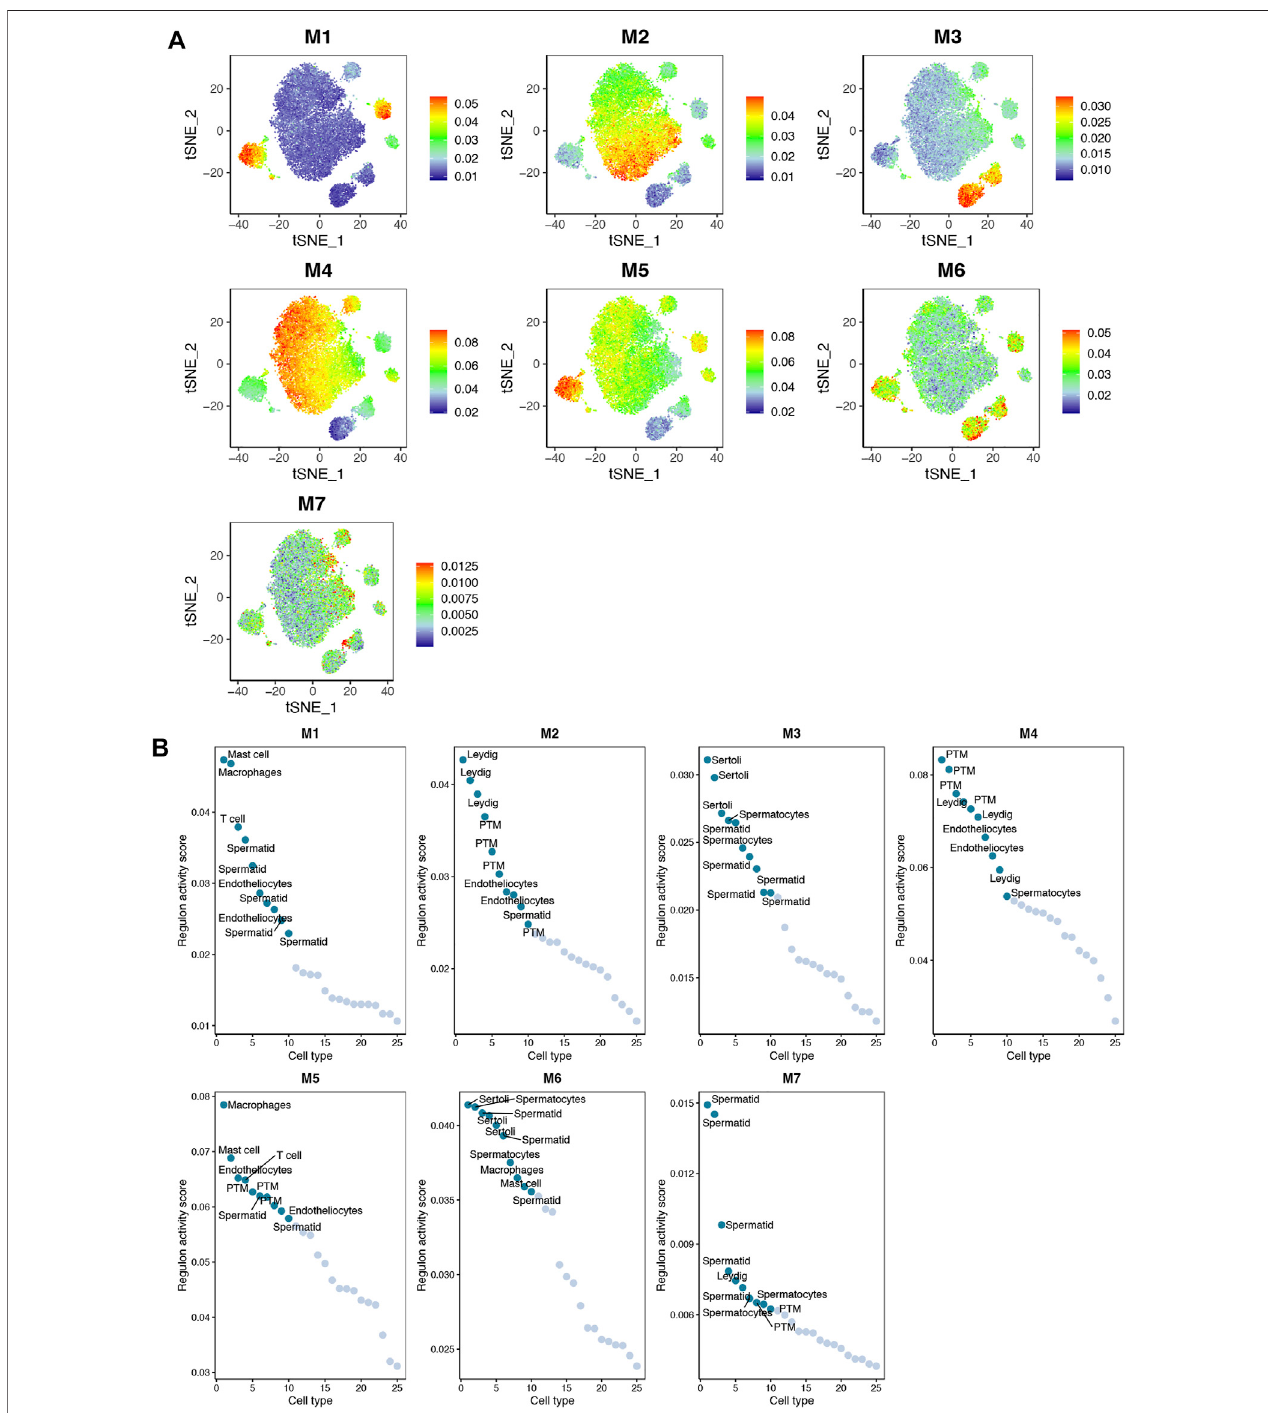
FIGURE 5 | The activity of regulatory modules in testicular somatic cells of different idiopathic non-obstructive azoospermia (iNOA) types. (A) Identi fi cation of the regulatorymodules(M1 – M7)accordingtotheregulatoryconnectionspeci fi cityindex(CSI)matrixandamapoftheaverageactivityofeachmodulebasedont-distributed random neighbour embedding (t-SNE). (B) Ranking regulation in iNOA testicular cells based on the regulation speci fi city score. The y -axis represents the regulation activity score. The x -axis represents the cell type.